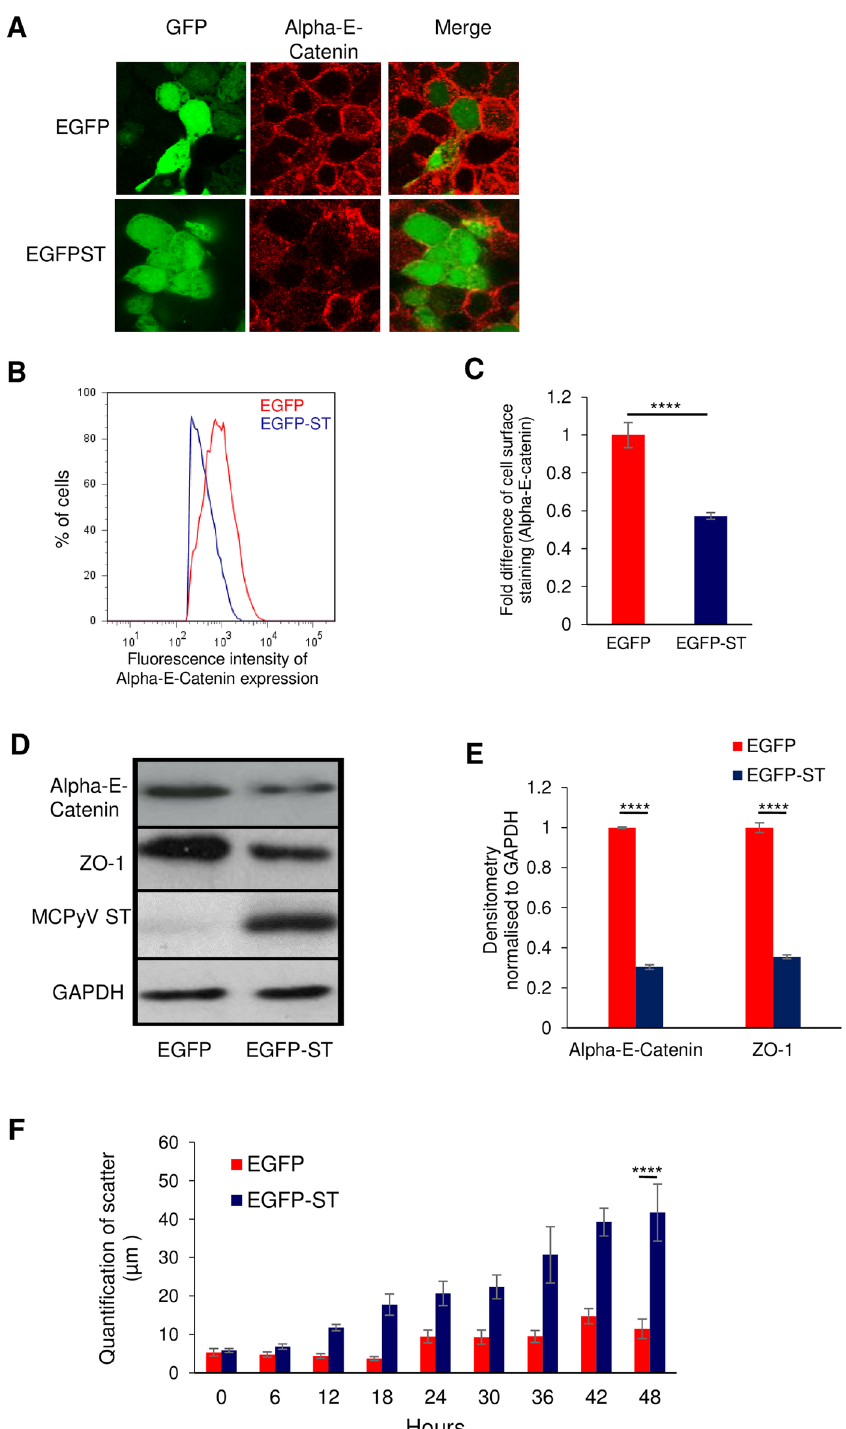
Fig 1. MCPyV ST expression induces cell dissociation by disrupting cell junctions. (A) HEK-293 cells were transfected with 1 μ g of pEGFP or pEGFP-ST expression plasmids. 24 h later cells were fixed and GFP fluorescence analysed by direct visualisation, whereas endogenous Alpha-E-catenin was identified by indirect immunofluorescence using a specific antibody. (B) EGFP or EGFP-ST transfected HEK-293 cells were harvested and stained with an Alpha- E-catenin specific antibody and Alexa-Fluor-tagged secondary antibody. Mean fluorescence intensity was analyzed using FlowJo software (C) Fold difference of cell surface staining was calculated using three replicates per experiment,